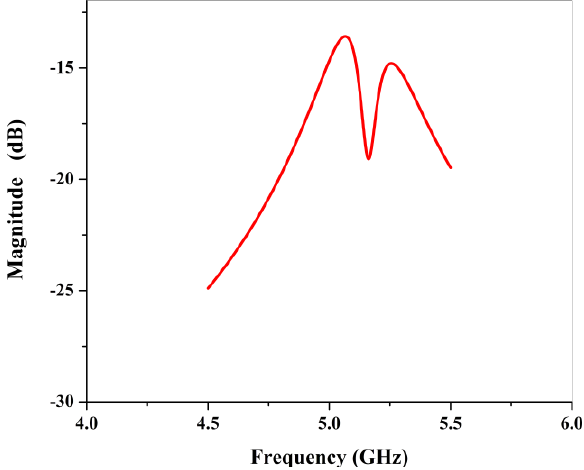
Figure 4: Splitting of dual modes of the patch resonator.